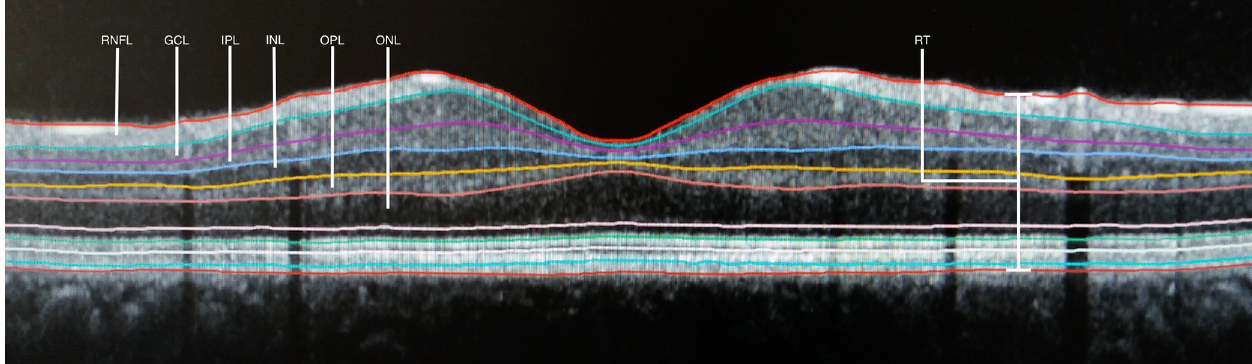
Fig 3. Cross-sectional representation of the macula showing the segmentation of retinal layers. From top to bottom: Retinal nerve fibre layer (RNFL), ganglion cell layer (GCL), inner plexiform layer (IPL), inner nuclear layer (INL), outer plexiform layer (OPL), outer nuclear layer (ONL); retinal thickness